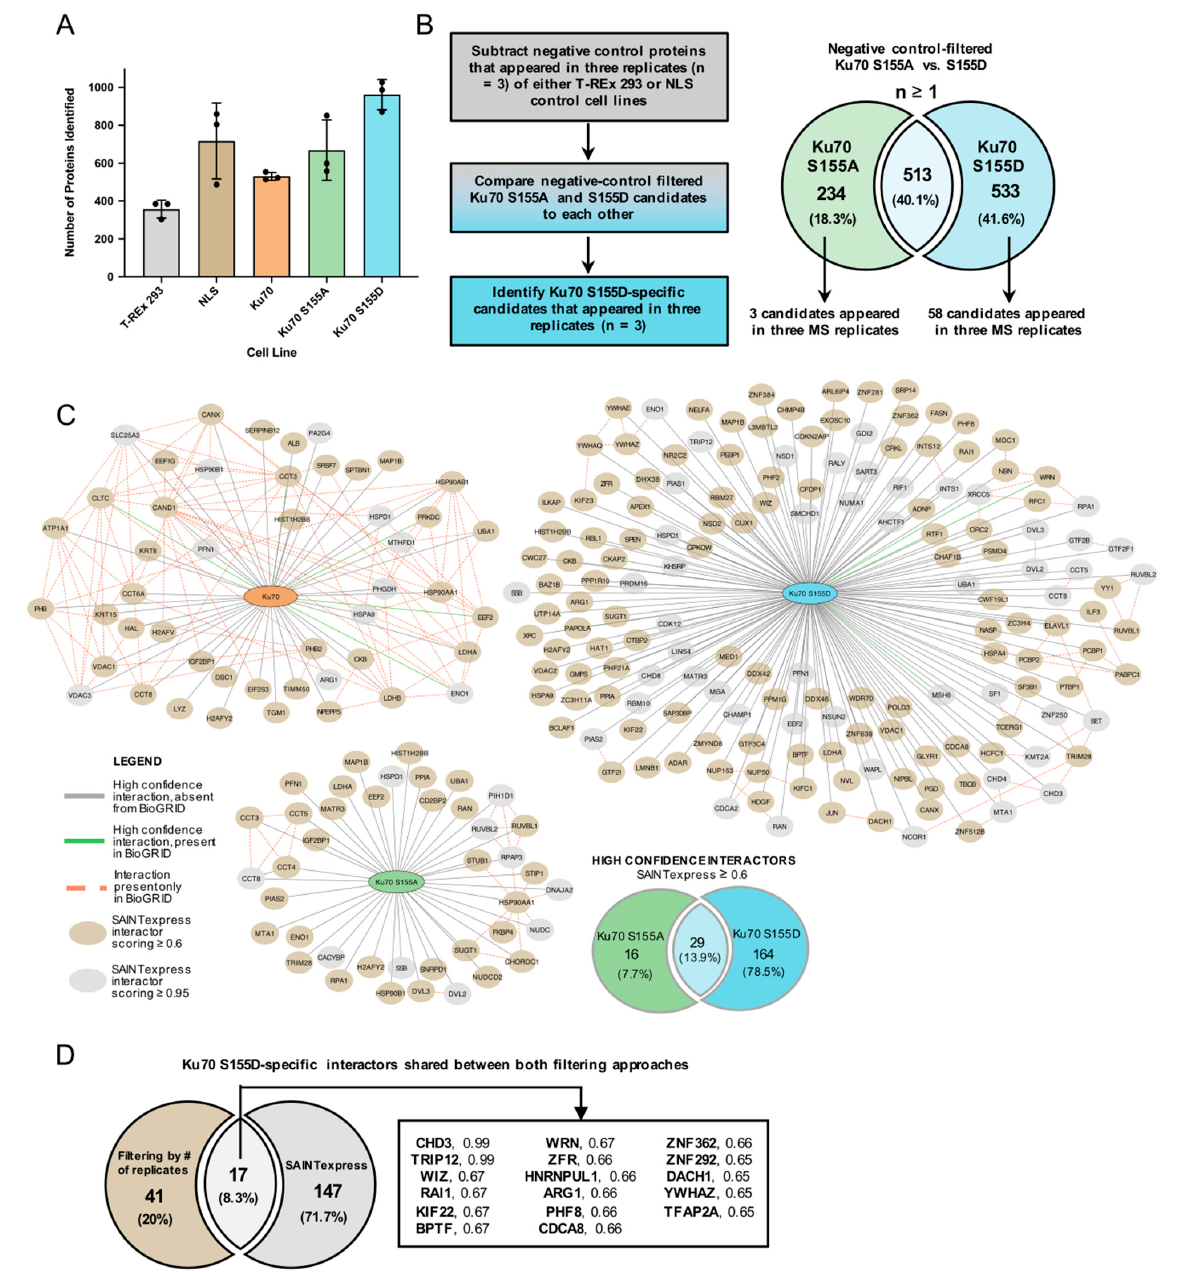
Figure 2. BioID2 candidate filtering and comparison process for final selection of Ku70 S155D-specific interactors: ( A ) total number of proteins identified in three biological replicates of BioID2 in Flp-In TM T-REx 293 stable cell lines: parental T-REx 293, NLS (Ku70)-BioID2, Ku70 WT-BioID2, Ku70